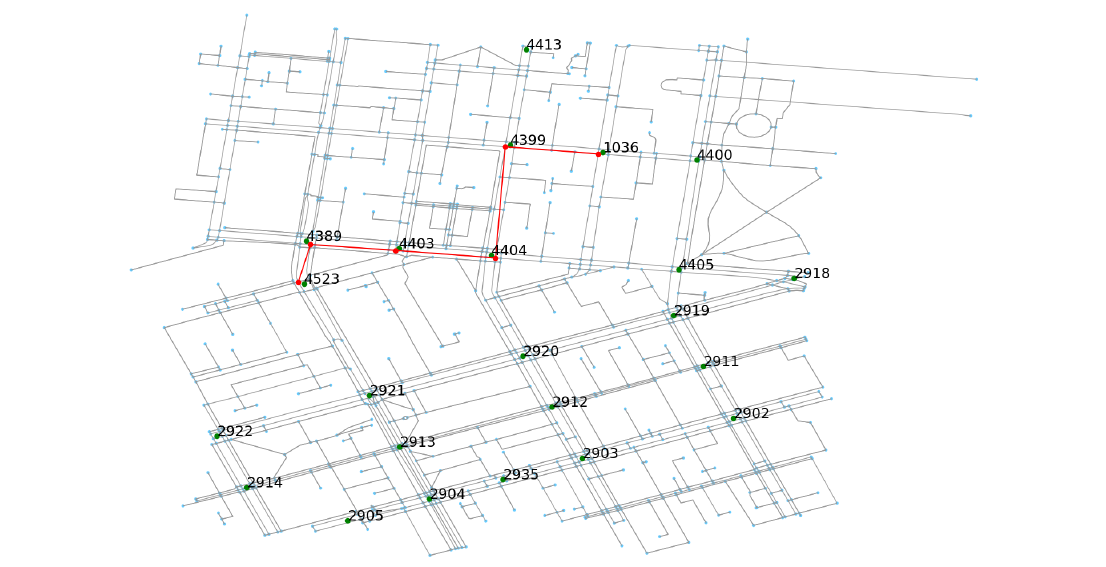
Figure 7. SCATS based path on top of the OSM-based bipartite